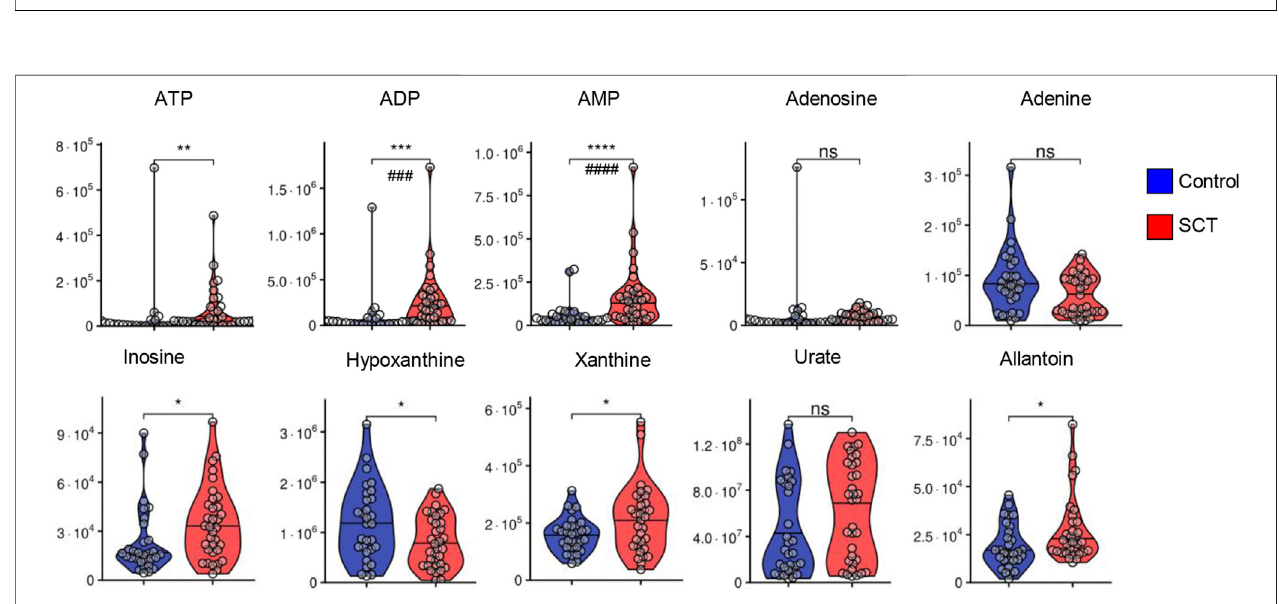
FIGURE5| Overviewofpurinemetabolism inplasmafromcontrol(blue)andsicklecelltrait (red)subjects.Asterisksindicatesigni fi cance (* p < 0.05;** p < 0.01;*** p < 0.001;**** p < 0.0001Wilcoxon/Mann-Whitney U -test).FDR-corrected p -valuesareprovidedforallanalytesin SupplementaryTableS1 andindicatedwith#using the same signi fi cance ranges as per the asterisks in p -values above.